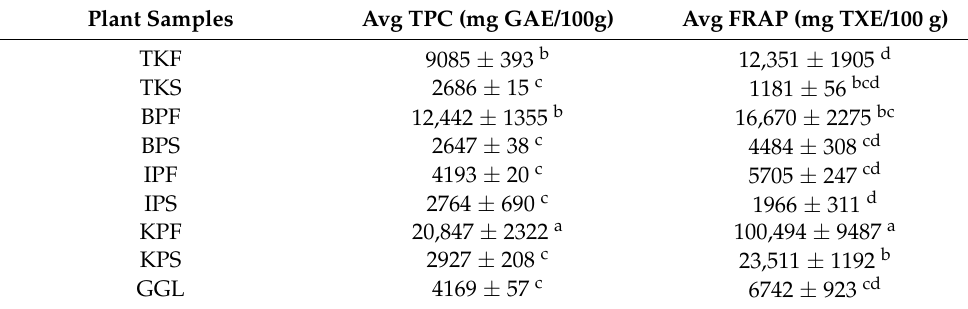
Table 1. Average TPC and antioxidant capacity of the plant